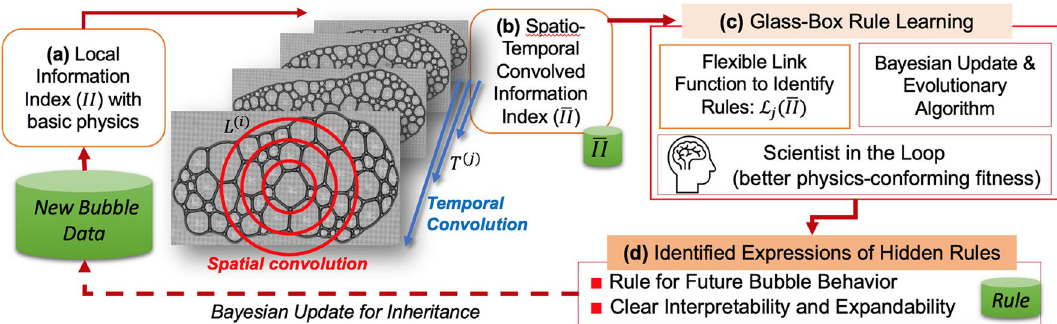
Figure 1. Overall architecture of the glass-box physics rule learner (GPRL) for identifying hidden rules of bubble array (adapted from 27 ): ( a ) Generate local information index with raw bubble data and infused basic physics; ( b ) Externalized information convolution to generate spatio-temporal convolved information index; ( c ) Rule learning core using flexible link functions, a combination of Bayesian update and evolutionary algorithm, and scientist-in-the-loop for infusing scientists’ knowledge into fitness (error) measures; ( d ) Remember the best-so-far expressions of identified rules and smooth knowledge inheritance with new bubble data. Shareable data sets are marked by green